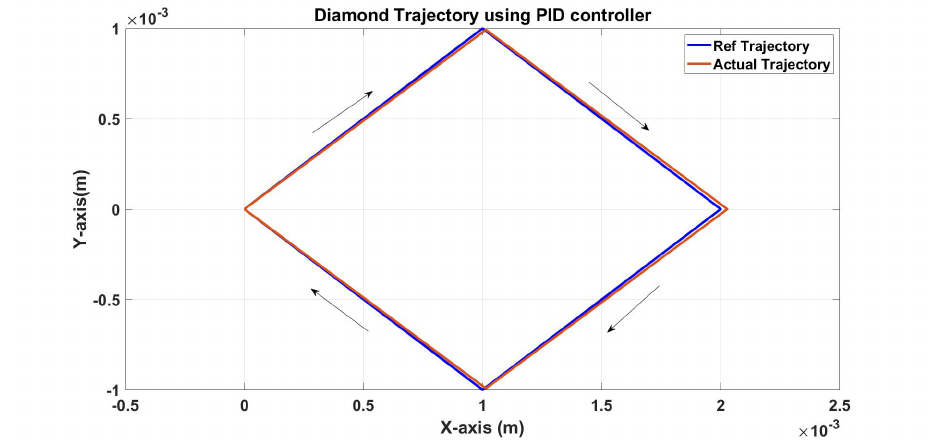
Figure 8. Simulation results of the diamond trajectory (reference and actual) using the PID controller.